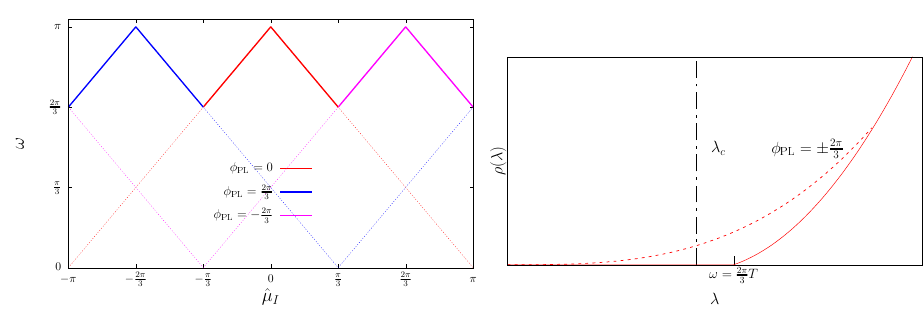
Figure 2. Left: gap function ω ( φ PL , ˆ μ I ) at finite imaginary chemical potential, for φ PL corresponding to the three centre elements of SU(3). Solid lines indicate the vacuum selected by fermions. Right: sketch of the spectral density at ˆ μ I = π . The solid line is the spectral density in the case of vanishing gauge T , while the dashed line qualitatively shows the spectral density after fields, starting at the gap ω = 2 π 3 the inclusion of localised modes penetrating the gap, and λ c indicates the position of the mobility